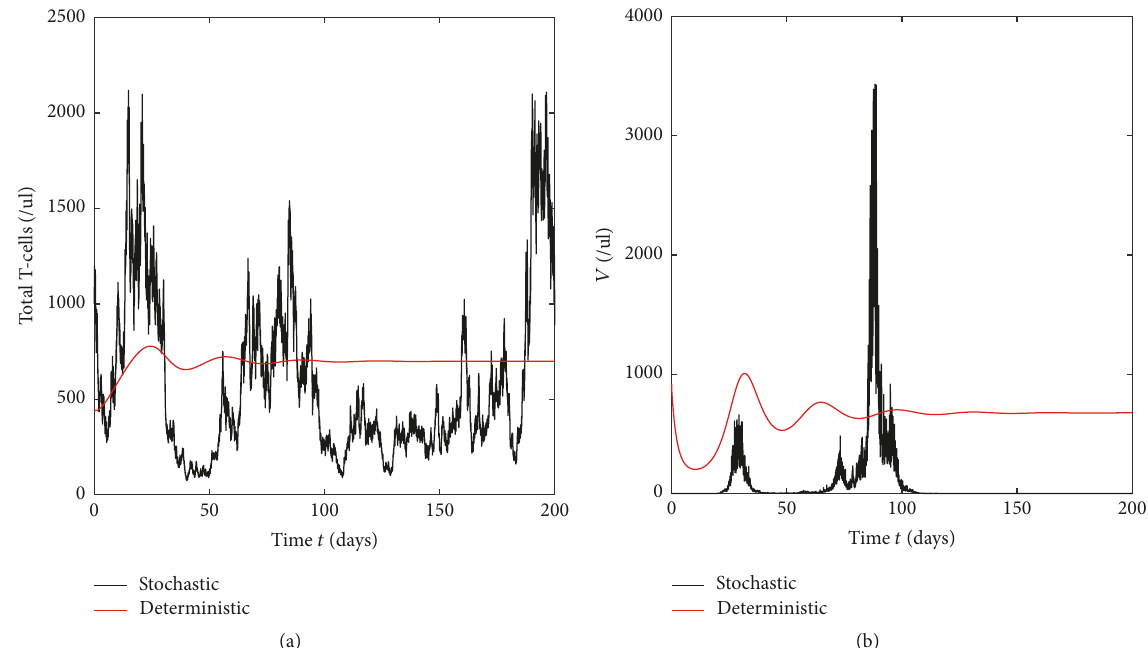
Figure 2: The virus can be eradicated for the stochastic model (5) when the white noises 𝜎 1 = 𝜎 2 = 𝜎 3 = 0.3 and 𝜎 4 = 1.5 , while the virus is prevalent for its corresponding deterministic